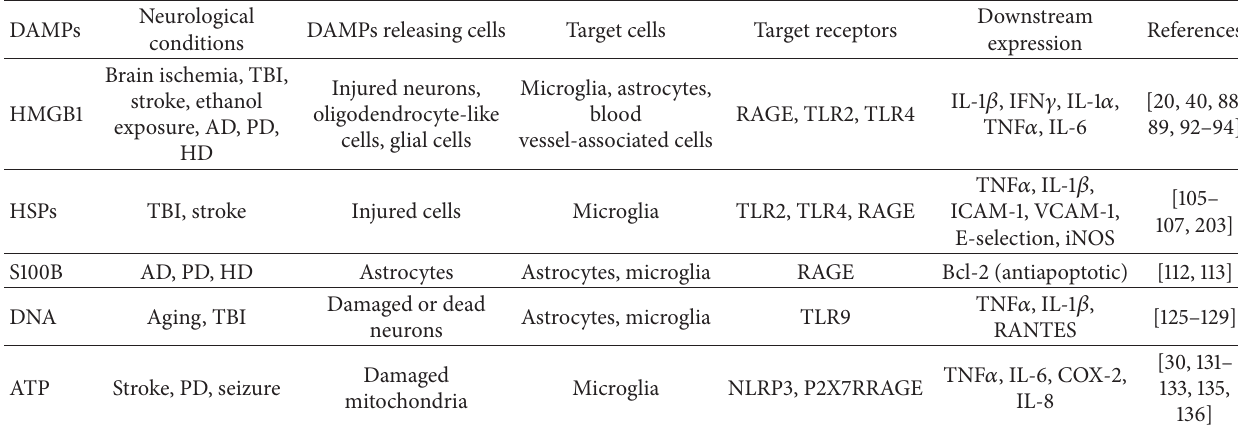
Table 1: A putative list of